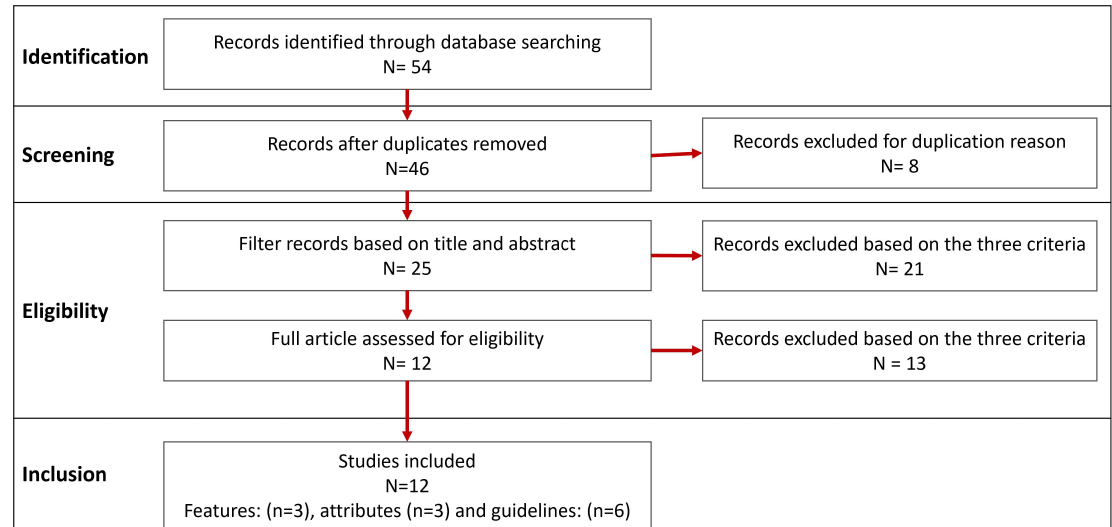
Figure 2. Flowchart for the systematic literature review of